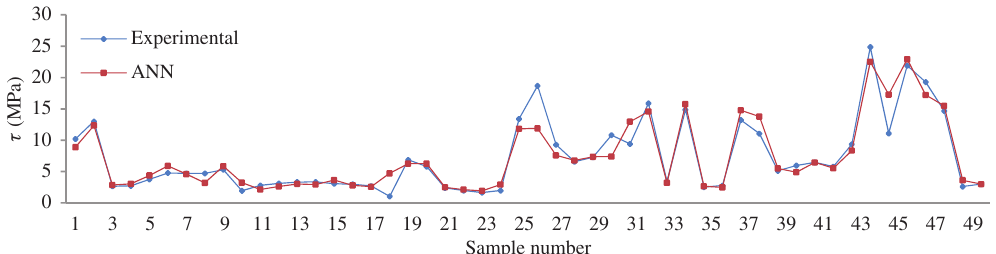
Figure 13: Comparison of the ANN model output and experimental data for testing.